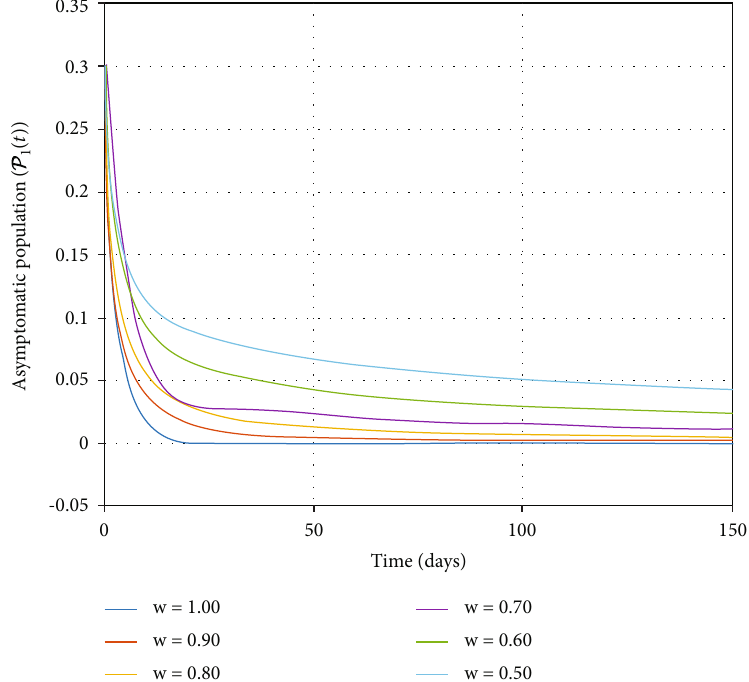
Figure 11: P ð t Þ by changing ω where m = 7 1